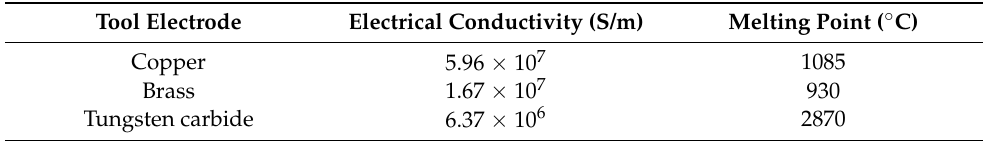
Table 1. Physical properties of tool